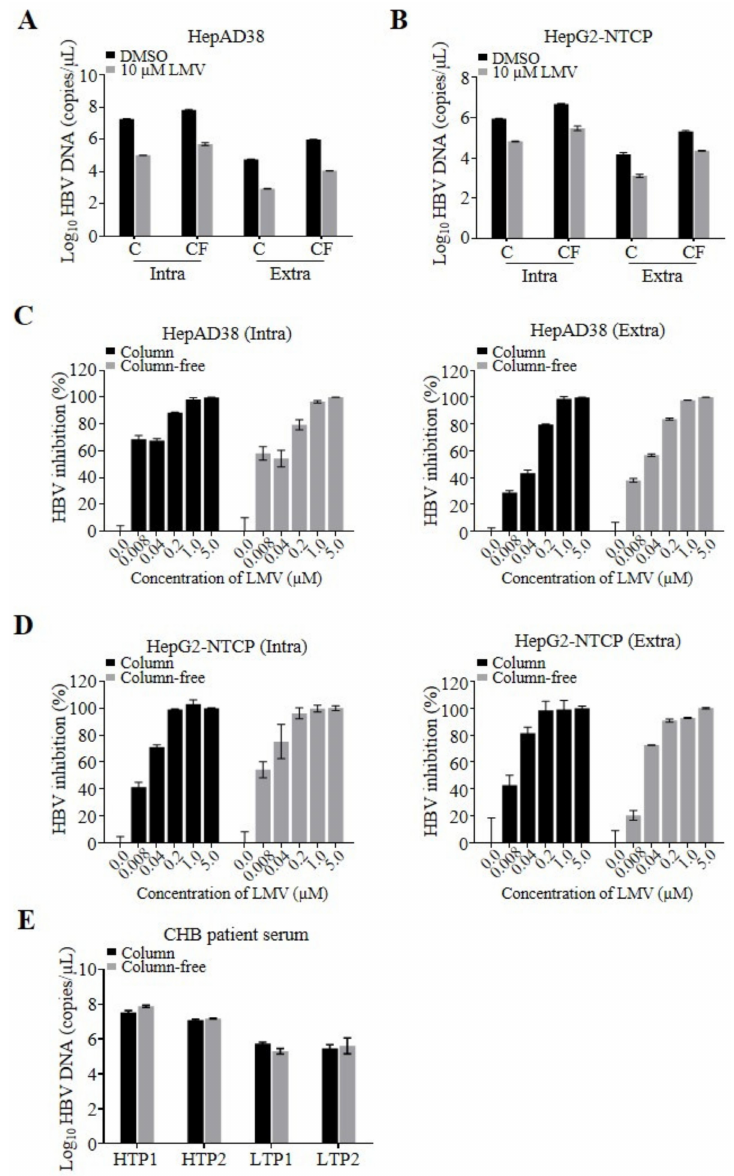
Figure 2. Assay development in 12-well plates. HepAD38 cells were seeded and treated with dimethyl sulfoxide (DMSO) or lamivudine (LMV) the following day. At 5 days post cell seeding, cells and supernatants were harvested for DNA preparation. HepG2-NTCP cells were infected with HBV at 1 day post cell seeding, and the next day viral inoculum was washed out, followed by DMSO or LMV treatment. At 7 days post-infection, cells and supernatants were harvested for DNA preparation. ( A , B ) qPCR analysis of HBV DNA isolated from HepAD38 ( A ) or HBV-infected HepG2-NTCP cells ( B ) and their culture supernatants in the presence of DMSO (black bars) or 10 µ M LMV (gray bars) using the column (C) or column-free method (CF). ( C , D ) HepAD38 ( C ) or HBV-infected HepG2-NTCP cells ( D ) were treated with LMV at the indicated concentrations. HBV DNA from the cells (Intra, left) and supernatants (Extra, right) were prepared using the column (black bars) or column-free method (gray bars) and analyzed by qPCR. HBV inhibition (%) was normalized by DMSO set as 0% inhibition, and 10 µ M LMV was set as 100% inhibition. Representative data of two independent experiments are shown as mean ± standard deviation (s.d.). ( E ) HBV DNA was extracted and isolated from the serum of patients chronically infected with HBV with high titer (HTP) or low titer (LTP) of virus using the column (black bars) or column-free (gray bars) method and analyzed by